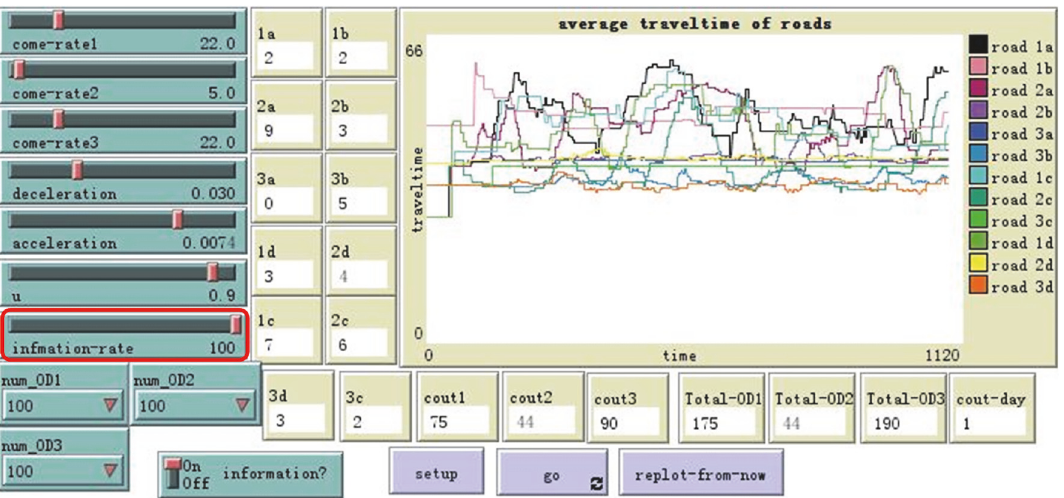
Figure 5: Interface of the simulation